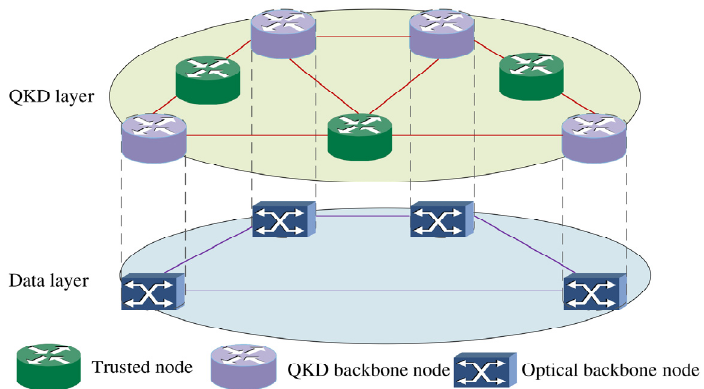
Figure 1. QKD network based on trusted relays.